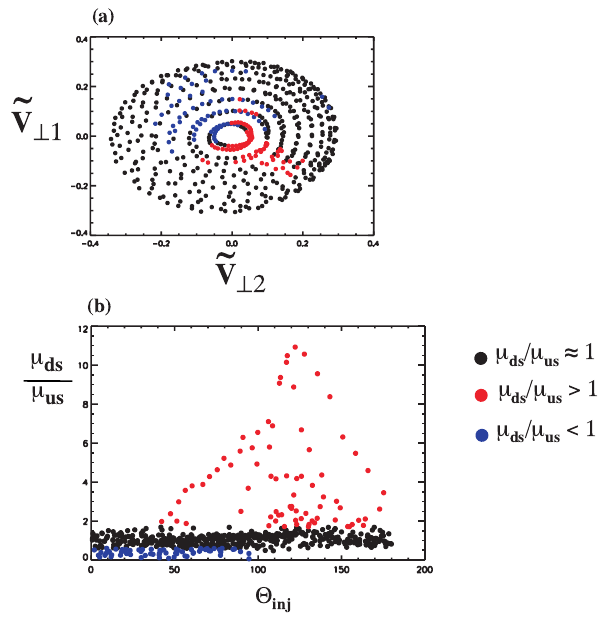
Fig. 8. (a) Projection of the shell in the local perpendicular velocity plane when the electrons hit the shock front (injection time). The same color code defined in Fig. 3 is used. Panel (b) shows magnetic moment ratio µ ds /µ us versus the injection angle θ inj , defined by the angle between the gyrating velocity and the shock normal when the particle hits the